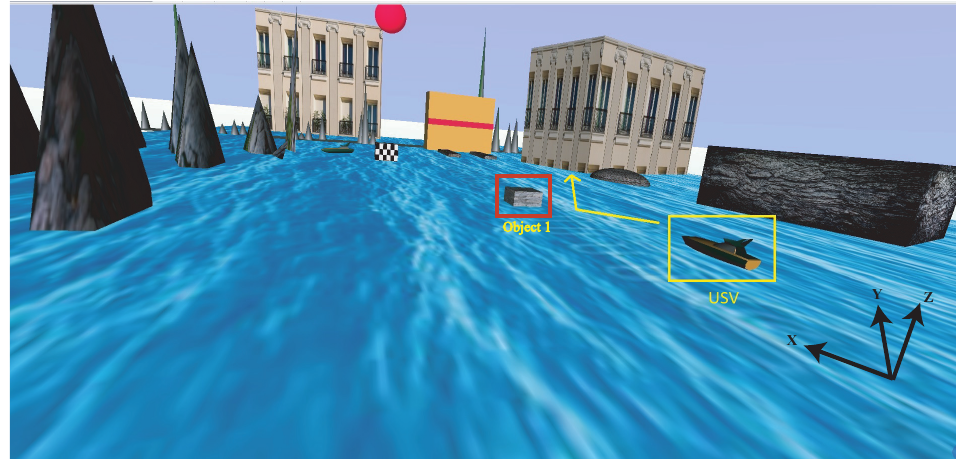
Figure 4. Virtual world environment.